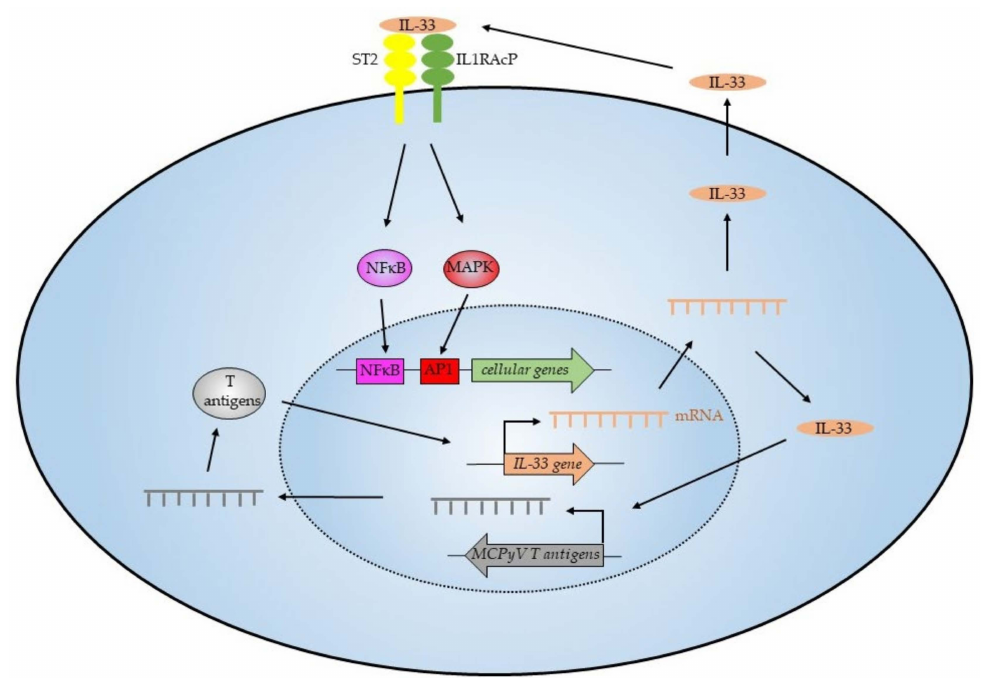
Figure 13. The IL-33/ST2 axis in MCPyV − positive MCC. The T-antigens of MCPyV stimulate expression of IL-33. Excreted IL-33 can bind to its receptors ST2 and IL1RAcP on the cell surface and this will activate the NF- κ B and MAPK pathways, subsequently resulting in the expression of NF- κ B and MAPK-responsive genes. IL-33 also increases the expression of the MCPyV T-antigens, and this will kindle an autostimulatory loop of IL-33